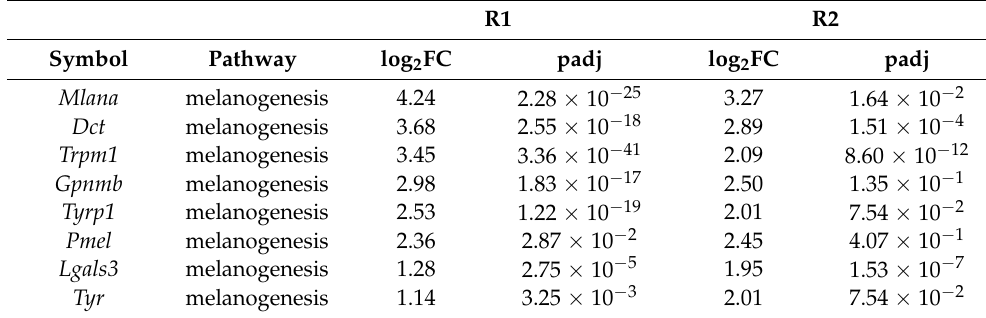
Table 3. Differential expression of selected melanogenesis genes in cluster C1.